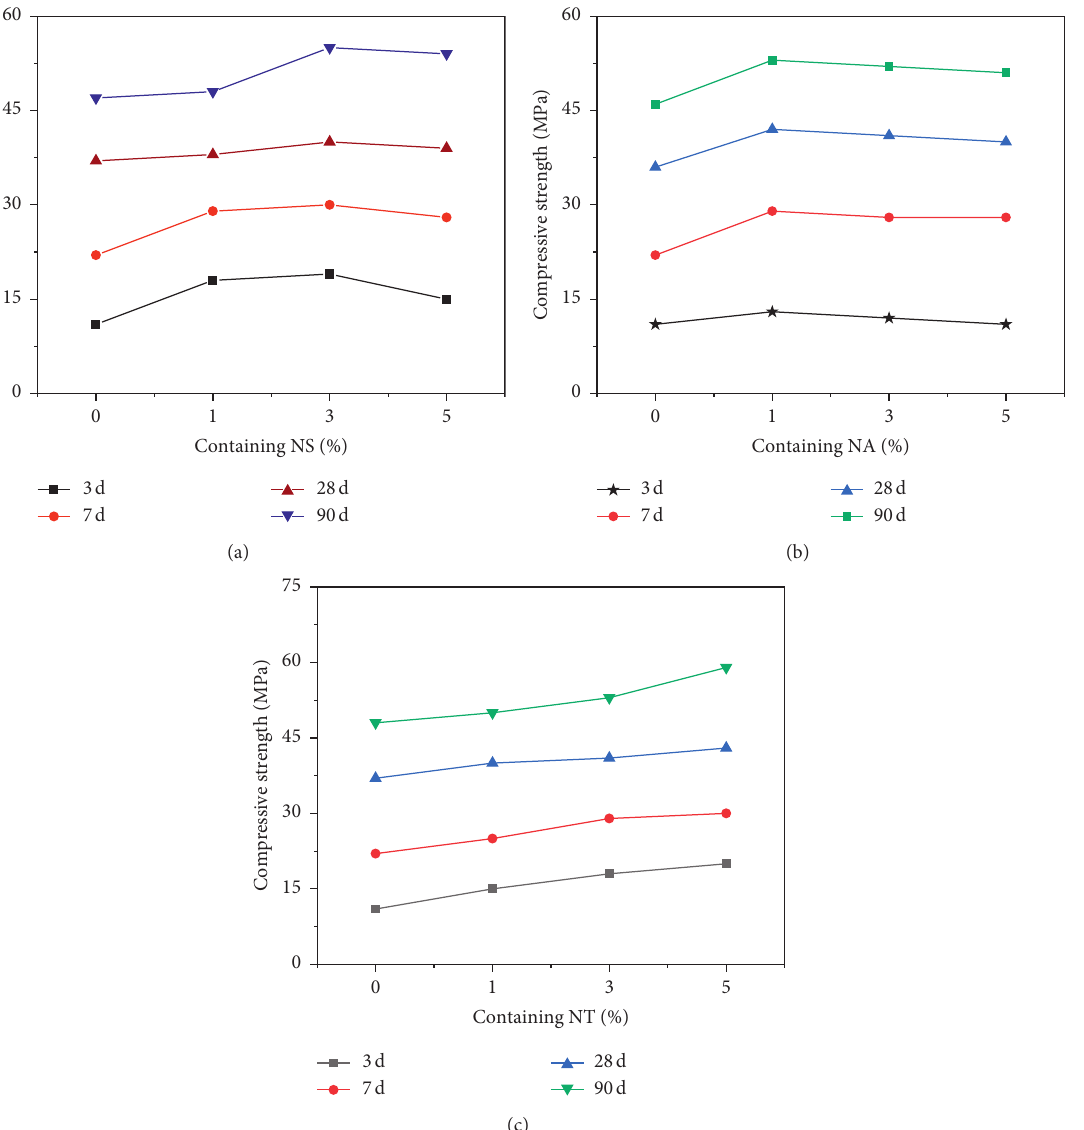
Figure 23: Variation of the compressive strengths of self-compacting mortars containing (a) NS, (b) NA, and (c) NT, at different ages